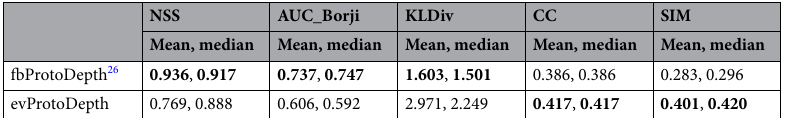
Table 1. Consolidated MIT saliency metrics Normalized Scanpath Saliency (NSS), Area under the ROC Curve (AUC-Borji), Kullback–Leibler Divergence (KLDiv), Pearson’s Correlation Coefficent (CC) and Similarity (SIM) 40–43 on the closest-object subset of the NUS3D dataset. A higher score is better for all metrics, excluding the KLDiv. Bold font indicates the model with the better performance. Some of the corresponding scenes and saliency maps are depicted in Fig. 3. The metrics for each individual image in this subset are presented in Supplementary Fig.